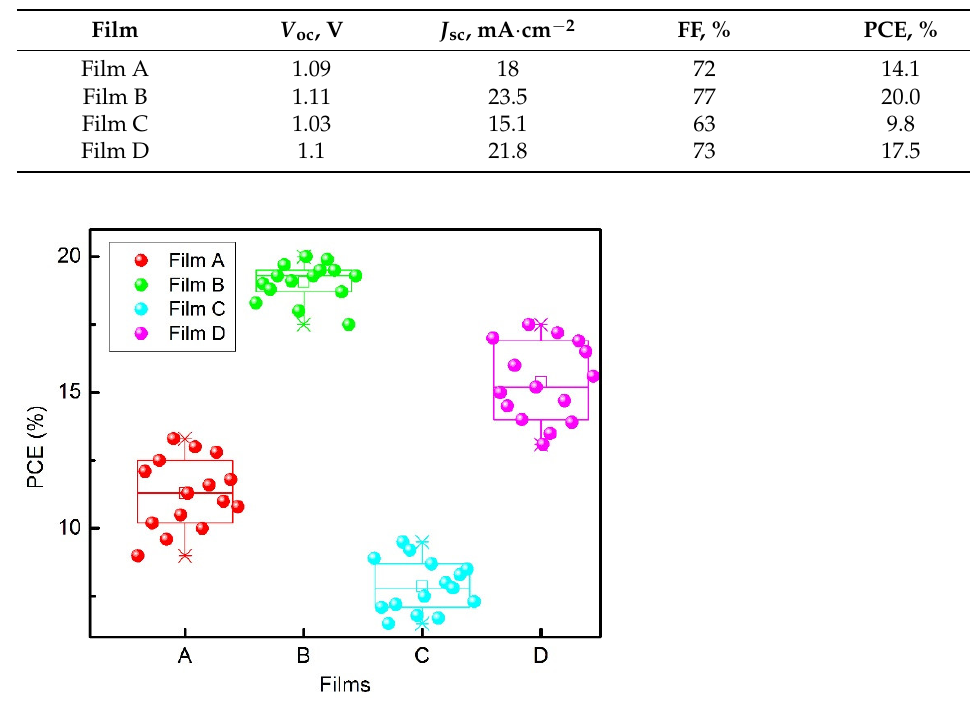
Table 3. Photovoltaic parameters of the solar cells on the base of different perovskite films. V oc is the open-circuit voltage; J sc is the short circuit current; FF is the fill factor; PCE is the power- conversion efficiency.